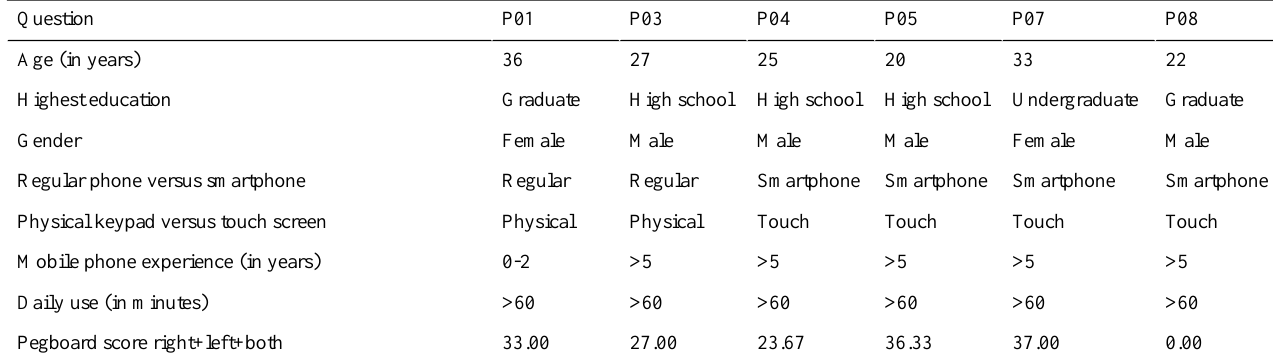
Table 1. Background of participants